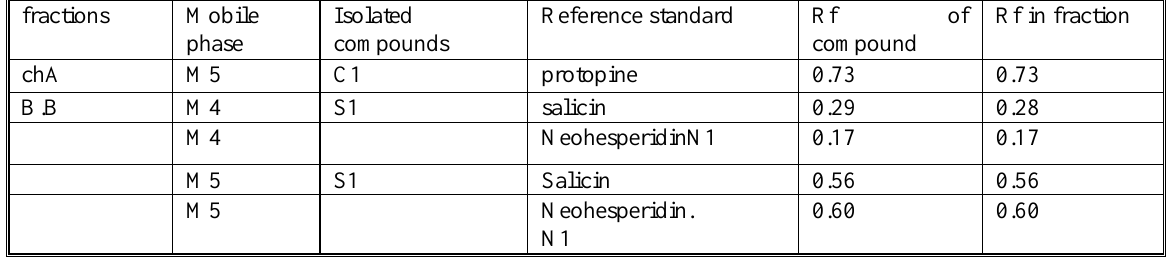
Table 1. Phenolic glycoside, flavonoids and Alkaloid content of different extract fraction detected by HPTLC and their max Rf value.